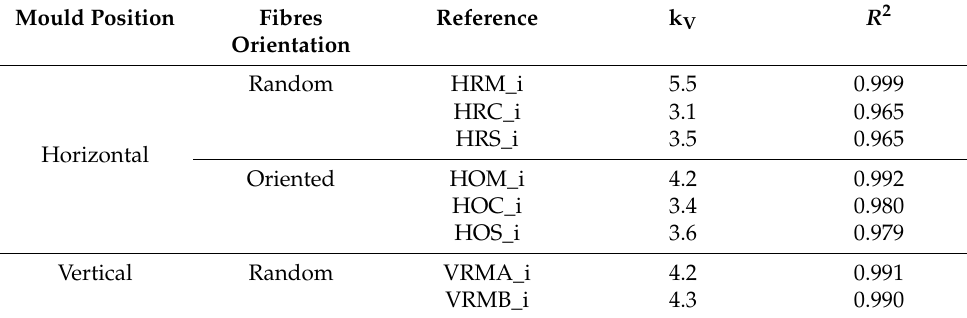
Table 6. Calibrating constant k V and R 2 of fitting lines.